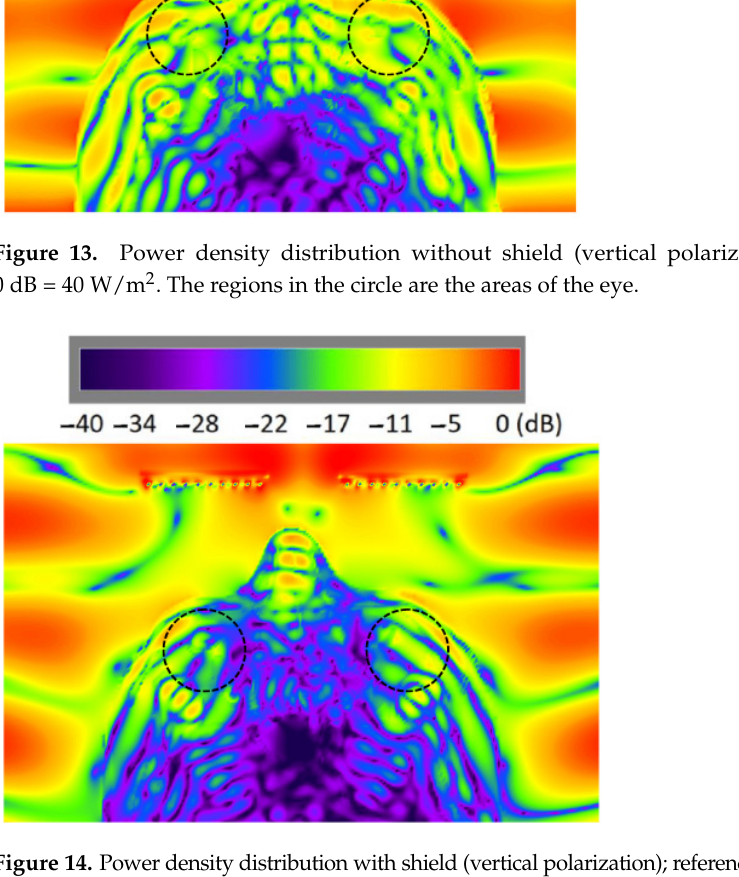
Figure 16. Power density distribution with shield (horizontal polarization); reference value 0 dB = 40 W/m 2 . The regions in the circle are the areas of the eye. The results of the simulations for the test points located in the eye tissues are pre- sented in Table 6. The points were as in previous cases, located in the regions of the eyelid, fat, lens, and eye vitreous tissues. The values of the Poynting vector for the model with and without a shield for the exposure to an EM wave with a vertical polarization are pre- sented in the aforementioned table. Table 6. Poynting vector for the model with and without shield, vertical polarization. Test Point Location Power Density without Shield [ 𝑾 𝒎 𝟐 ]